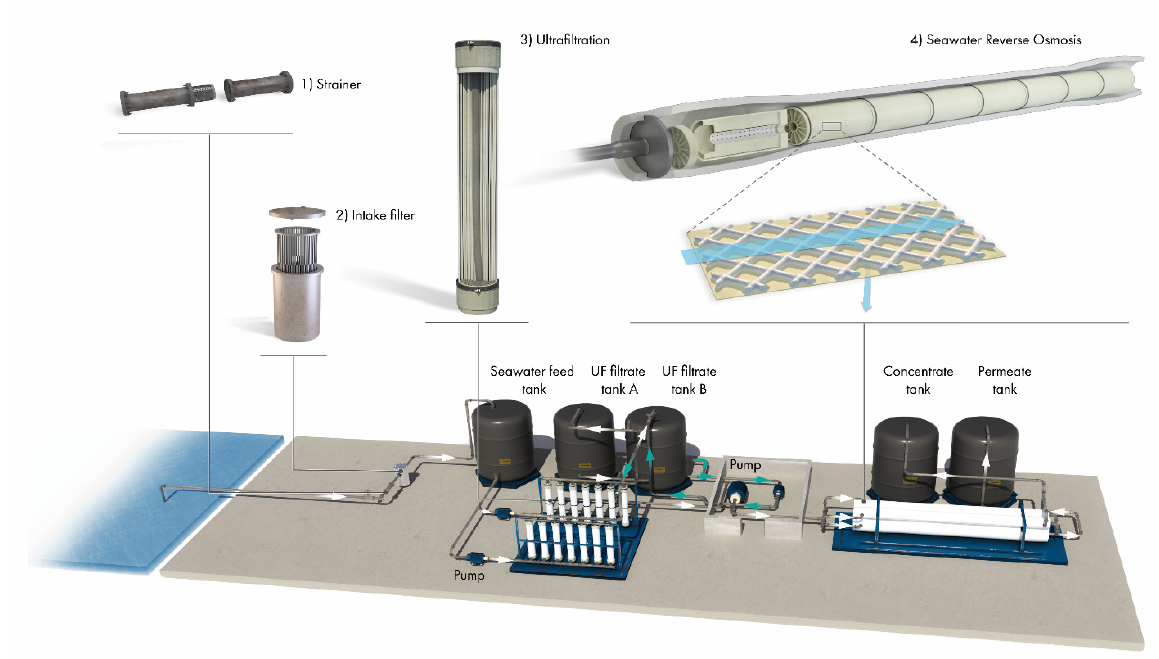
Figure 1. Schematic of the seawater reverse osmosis pilot used for the study, operated with seven 8” diameter spiral wound SWRO membrane modules in series. 8” diameter spiral wound SWRO membrane modules in